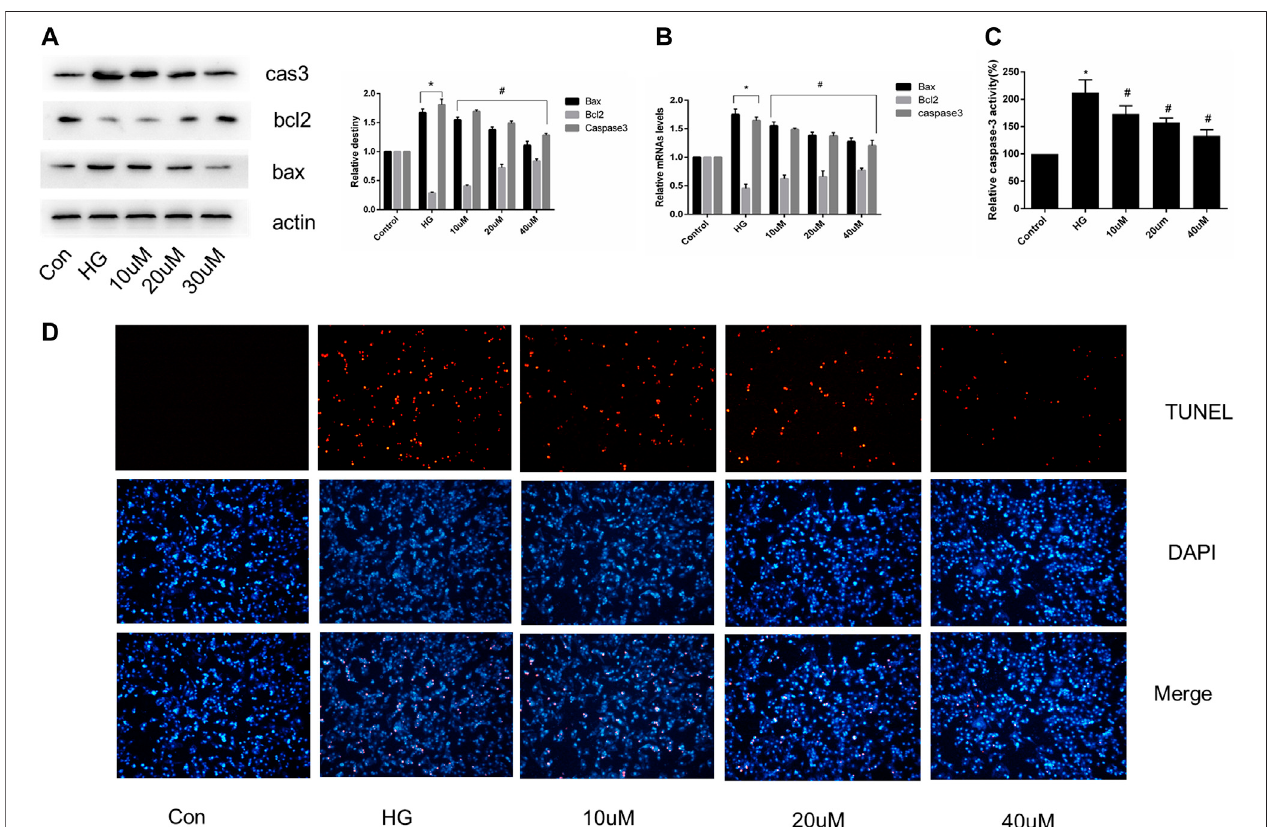
FIGURE 6 | SGLT1 inhibition relieved apoptosis in H9C2 cells. H9C2 cells were treated with 10, 20, or 40 µM mizagli fl ozin for 24 h, followed by treatment with or without 30 mmol/L HG. (A) Relative protein levels of bax, bcl2, and caspase-3. (B) RT-PCR analysis of bax, bcl2, and caspase-3. (C) Caspase-3 activity in H9C2 cells. (D) Apoptotic rate of H9C2 cells measured by TUNEL staining. * p < 0.05 vs control; # p < 0.05 vs DCM. Experiments were performed in